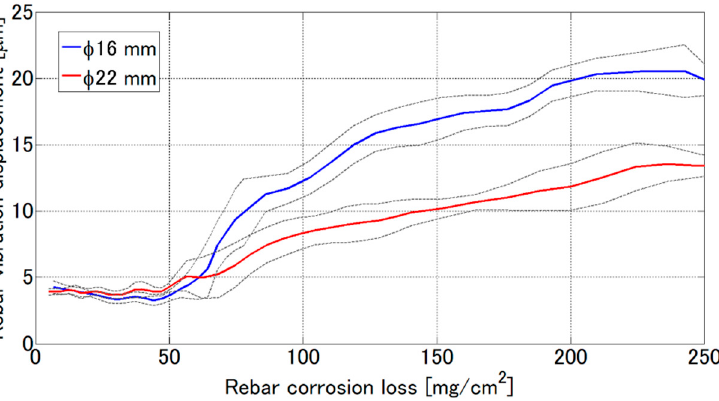
Figure 15. Relationship between rebar corrosion loss and rebar vibration displacement obtained by VDR. The grey dotted lines mean standard deviation. VDR. The grey dotted lines mean standard